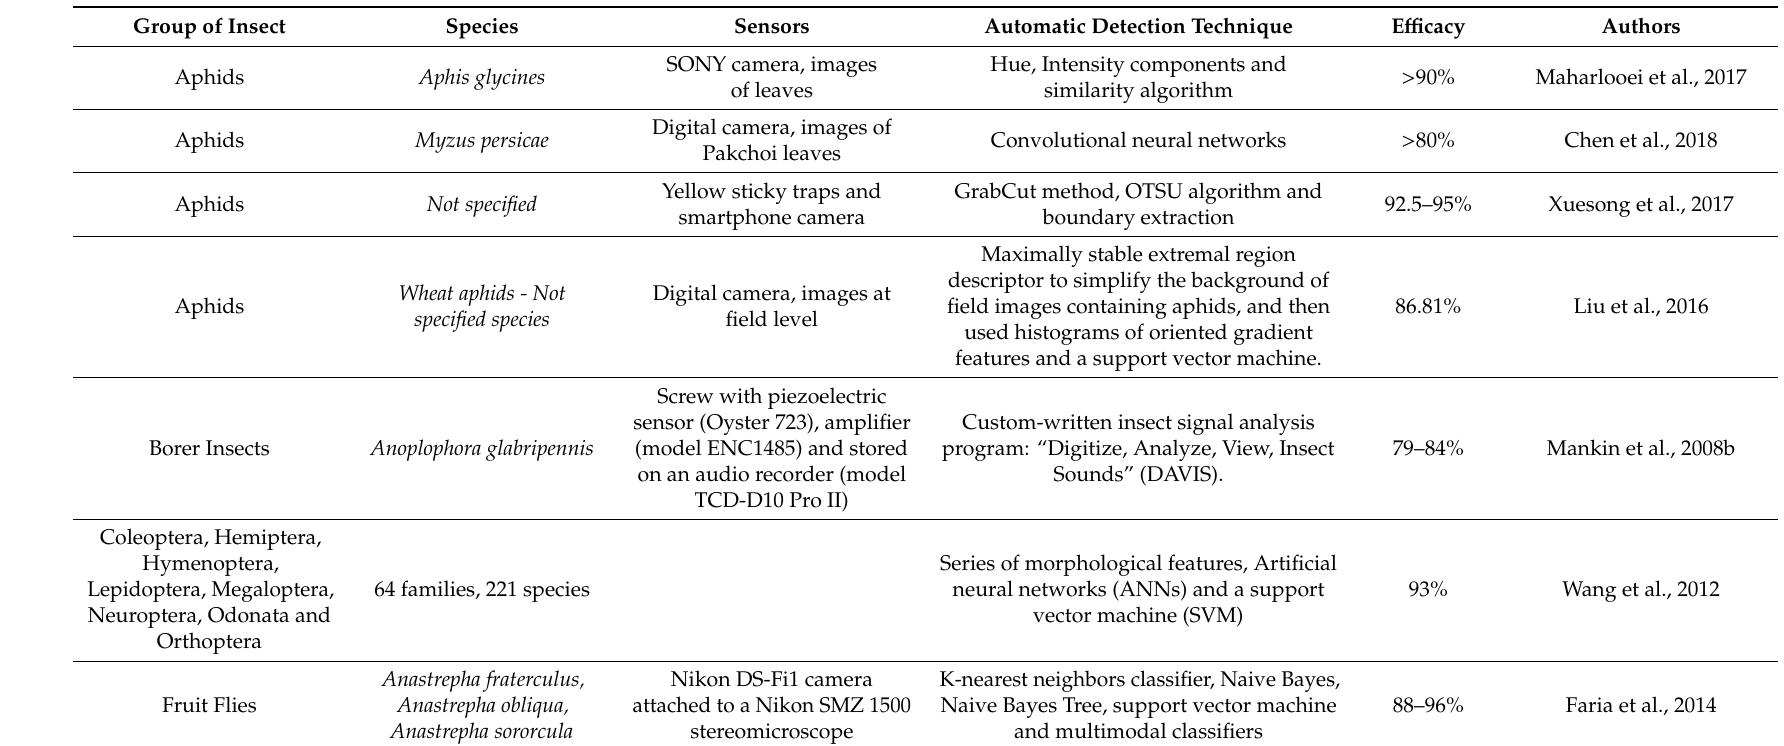
Table A1. Automatic Detection Techniques, Sensors and E ffi cacy for Di ff erent Insect